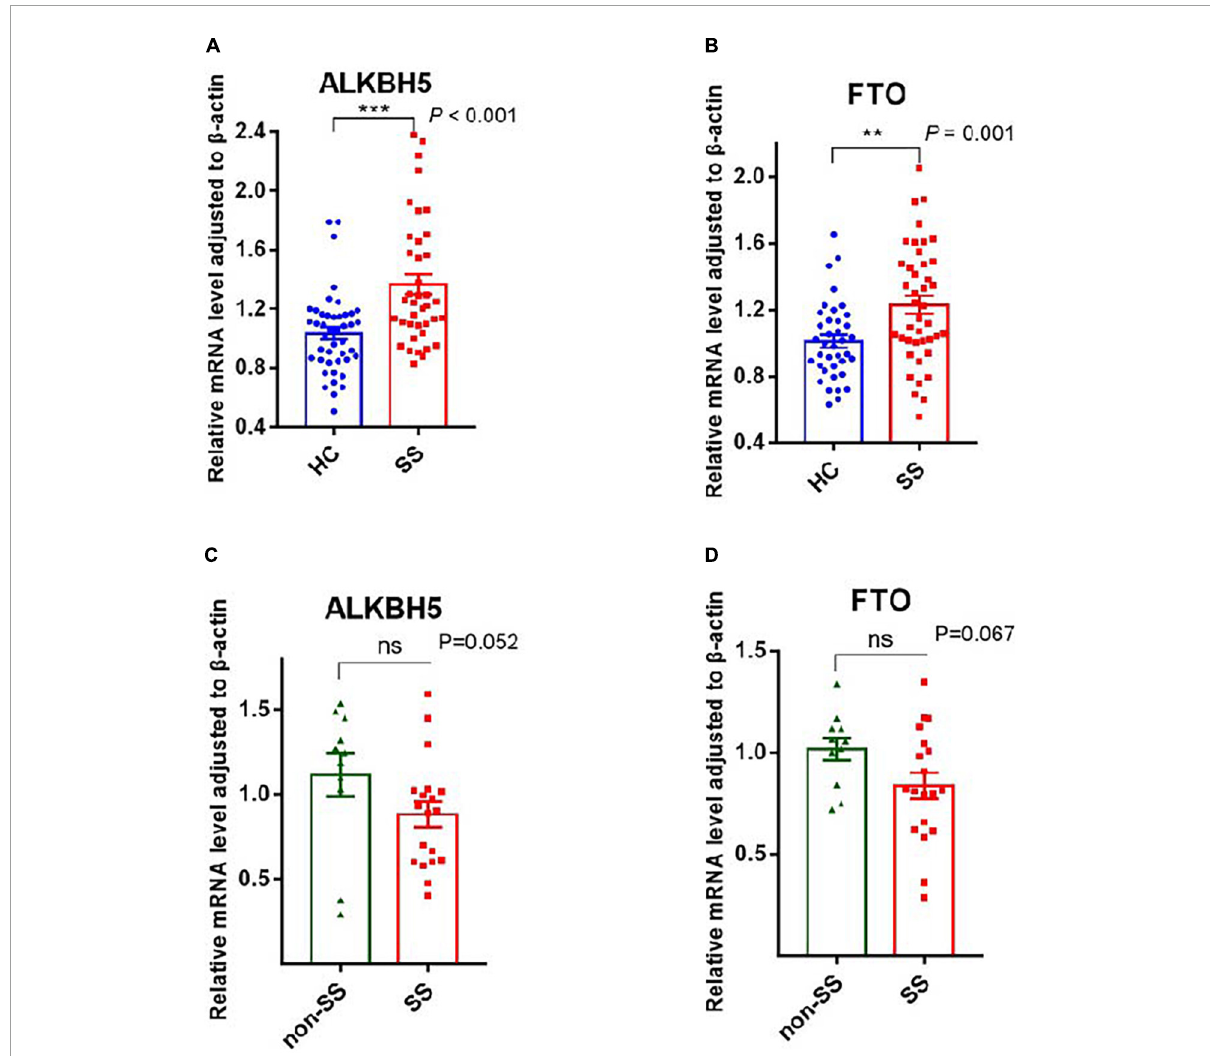
FIGURE2 Messenger RNA (mRNA) levels of N6-methyladenosine (m6A) erasers in peripheral blood mononuclear cells (PBMCs) from patients with primary Sjögren’s syndrome (pSS), patients with non-SS sicca, and healthy controls (HCs). (A,B) The mRNA levels of ALKBH5 and FTO in PBMCs from patients with pSS were higher than HCs. (C,D) No significant difference was found in the expression of ALKBH5 and FTO between patients with pSS and patients with non-SS sicca. ** p < 0.01 and *** p <